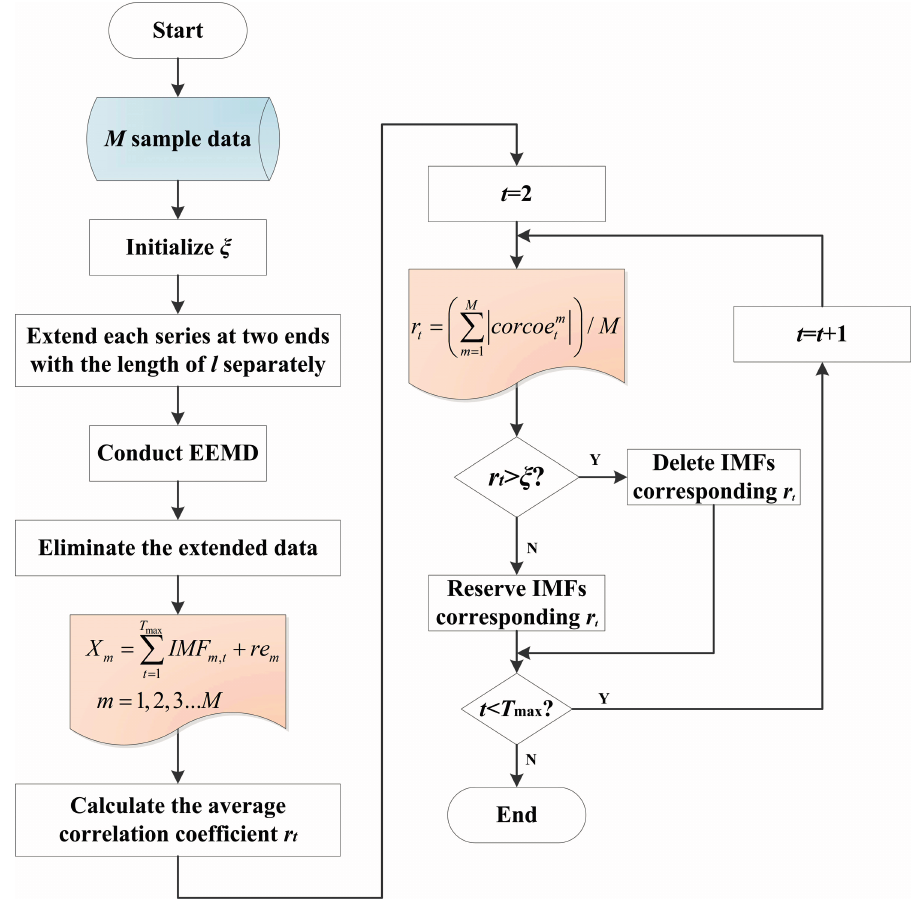
Figure 1. Flowchart of improved